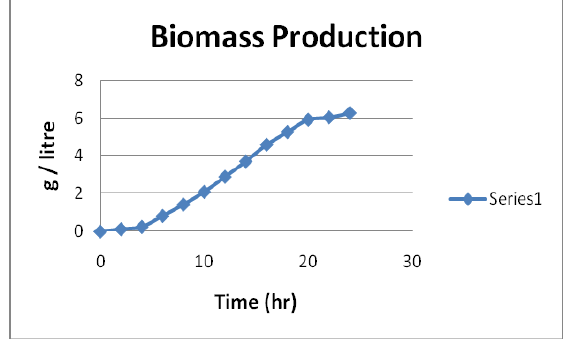
Figure 6. Biomass production at different time intervals.